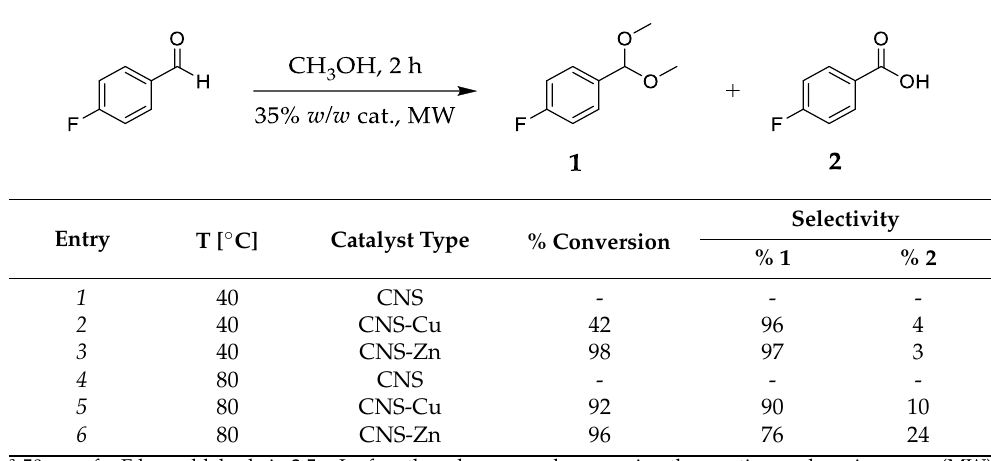
Table 3. Optimization of the reaction temperature in methanol a .